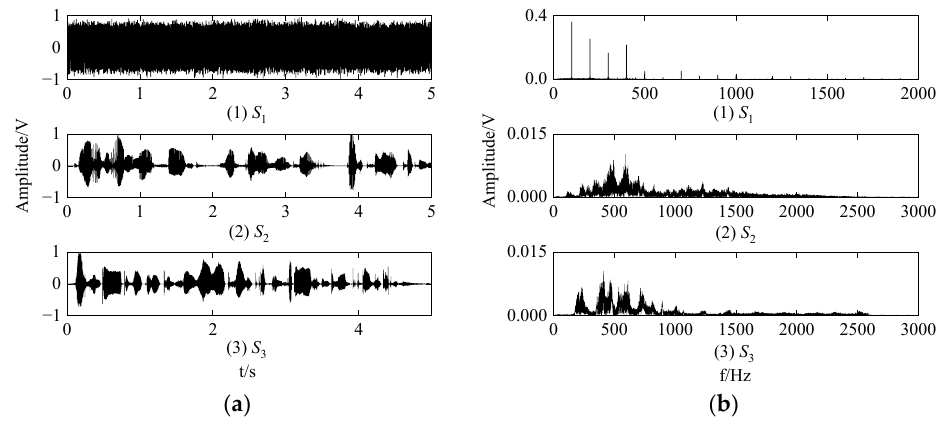
Figure 4. Waveforms and spectrums of the source signals; (( a ): waveforms; ( b ): spectrums.).